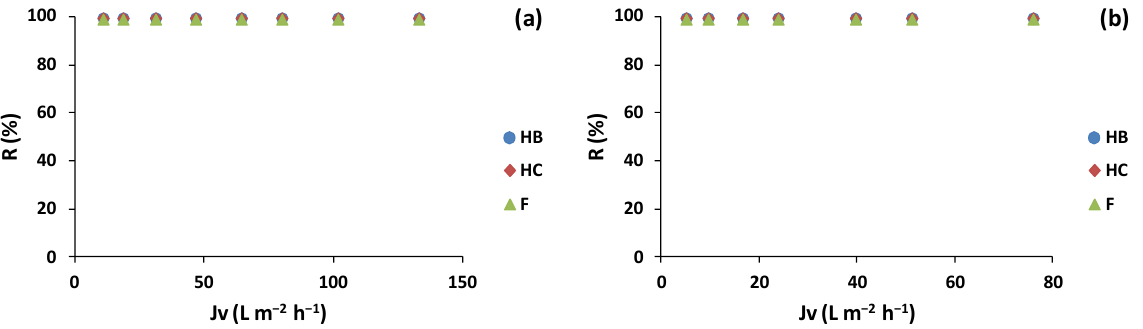
Figure 8. Polyphenol families (hydroxybenzoic acids (HB), hydroxycinnamic acids (HC), and flavonoids (F)) rejection with trans-membrane flux for ( a ) lees filters and ( b ) olive pomace extracts with BW30LE membrane.